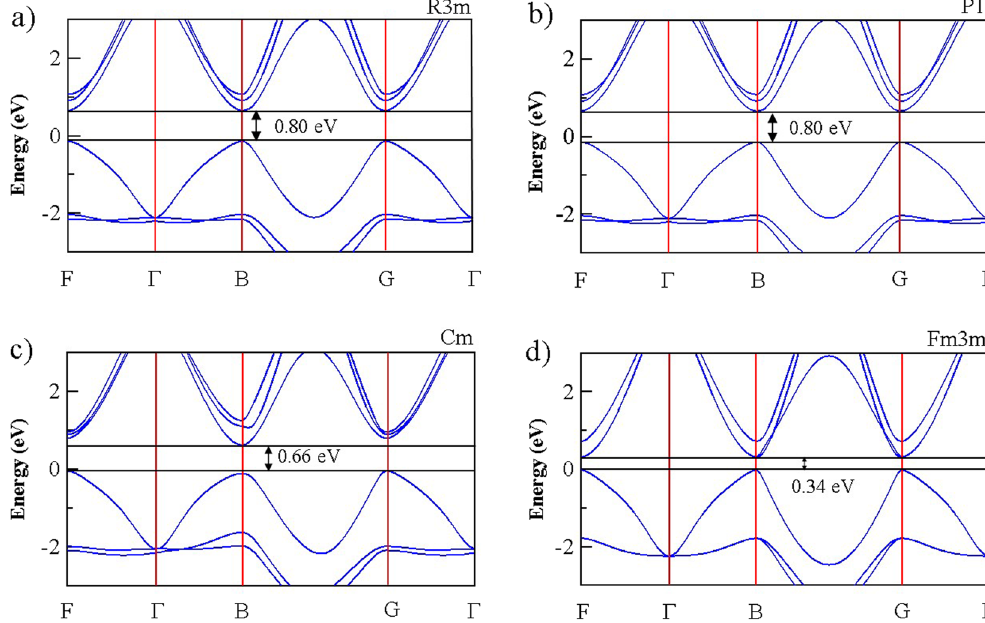
Figure 5. Calculated band structure of each crystalline structure for ( a ) R3m, ( b ) P1, ( c ) Cm, and ( d ) Fm3m. R3m and P1 have almost the same band gap (0.80 eV), while Cm has a lower band gap (0.66 eV) and Fm3m has the lowest band gap (0.34 eV). These various band gaps cause the resistance difference between samples containing different portions of the various crystal